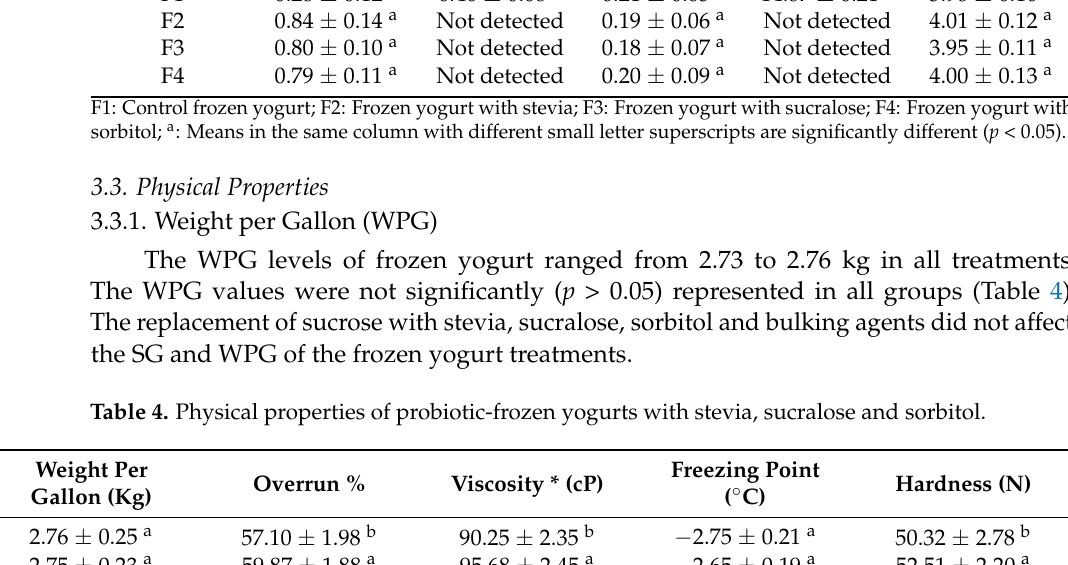
Table 3. Carbohydrate profiles of probiotic-frozen yogurts with sweeteners and filler agents. Treatments